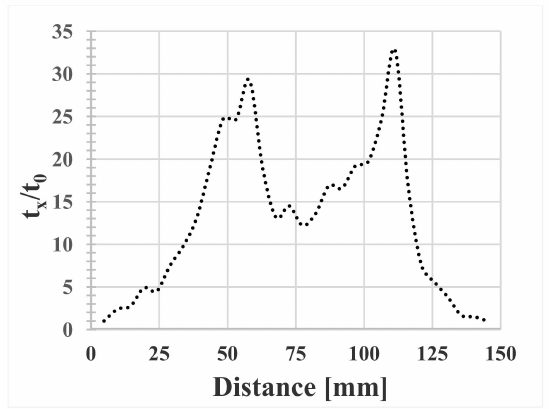
Figure 22. Relative homogenization time in the billet cross